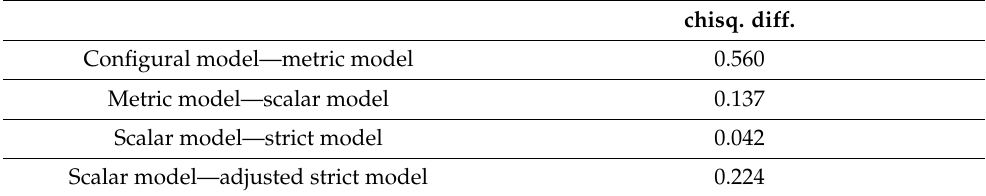
Table 9. Differences between chi-square statistics for age